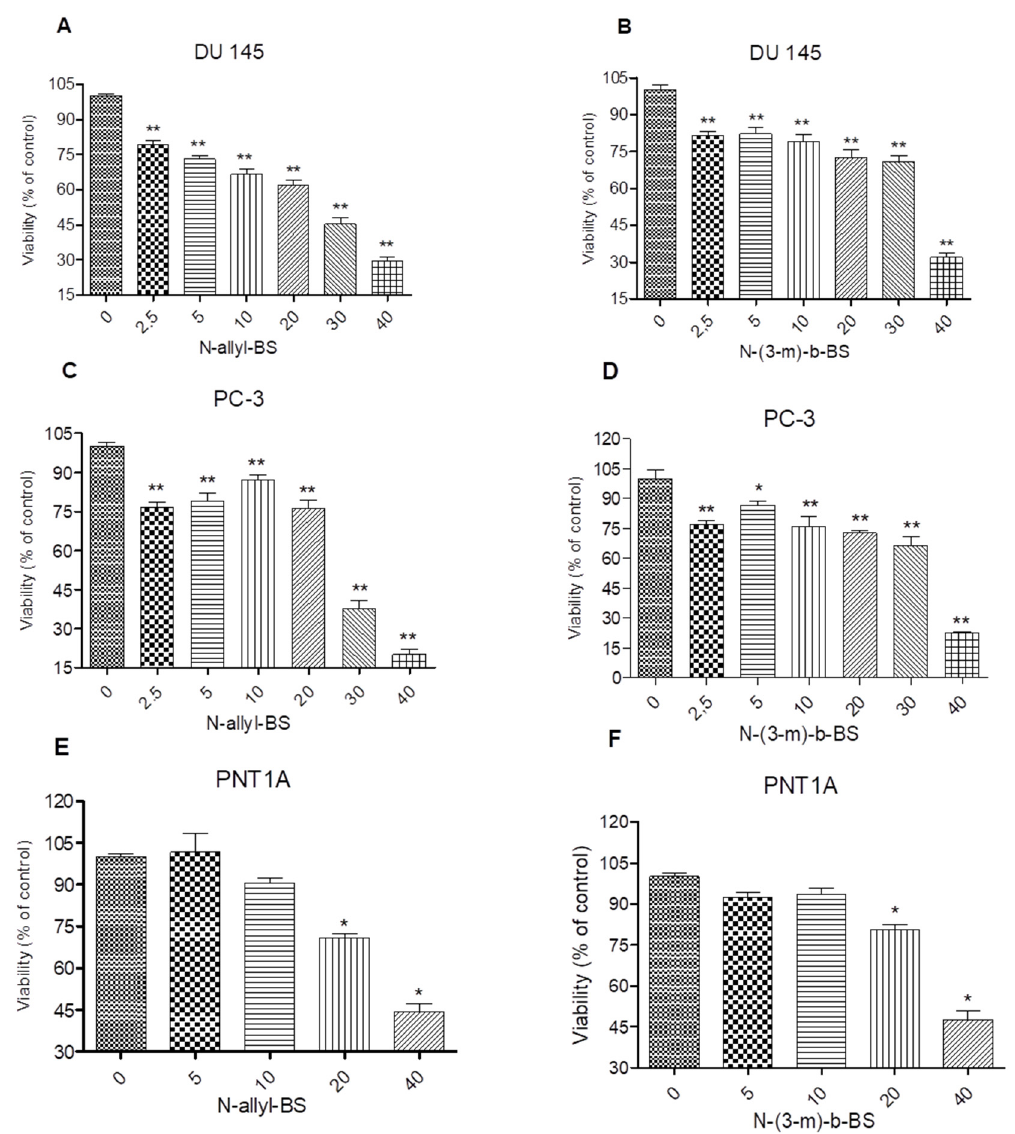
Figure 2. N -allyl-BS and N -(3-mb)-BS respectively inhibit viability of DU 145 ( A , B ) and PC-3 ( C , D ) prostate cancer cells in a dose dependent manner, while normal prostate cells PNT1A ( E,F ) are more resistant. The cells were treated with indicated concentrations of N -allyl-BS or N -(3-mb)-BS for 24 h. Viability was determined using SRB assay. Data are presented as mean ± SE (n = 3); significance of variation was calculated using one-way ANOVA followed by Dunnett’s multiple comparison test. (* P < 0.01) (** P < 0.001).